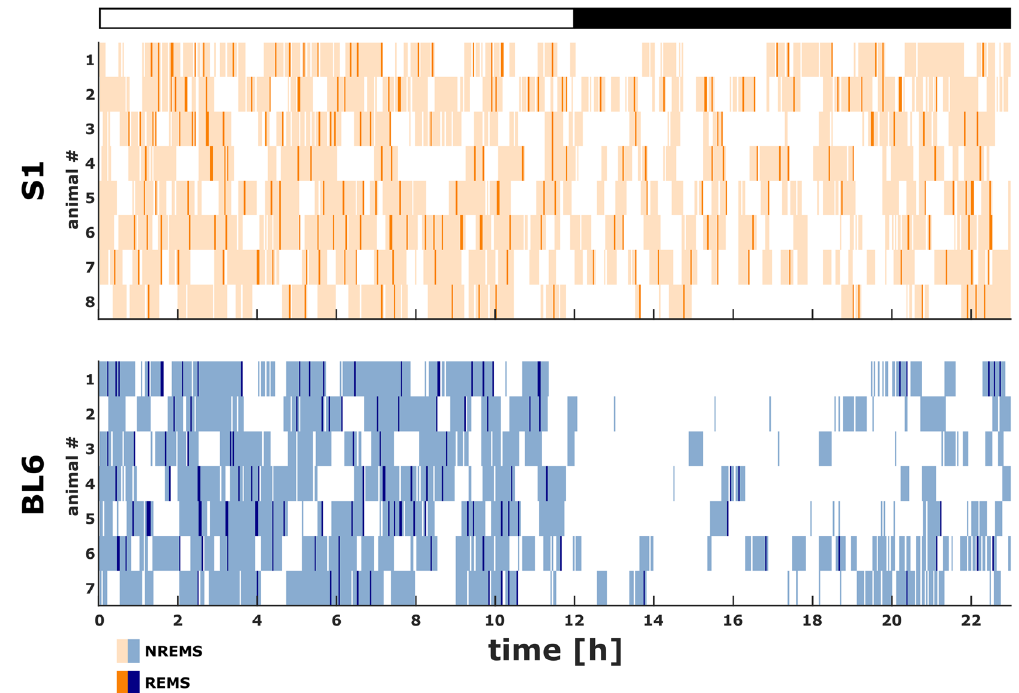
Figure 1. 23 h hypnograms of S1 (n = 8) and BL6 (n = 7) mice. S1 mice displayed a less pronounced diurnal rhythmicity with more fragmented sleep/wake patterns and a higher amount of sleep intrusions in the dark period. White and black bars at the top represent light period (Zeitgeber time: h0–h12) and dark period (Zeitgeber time: h12–h23),